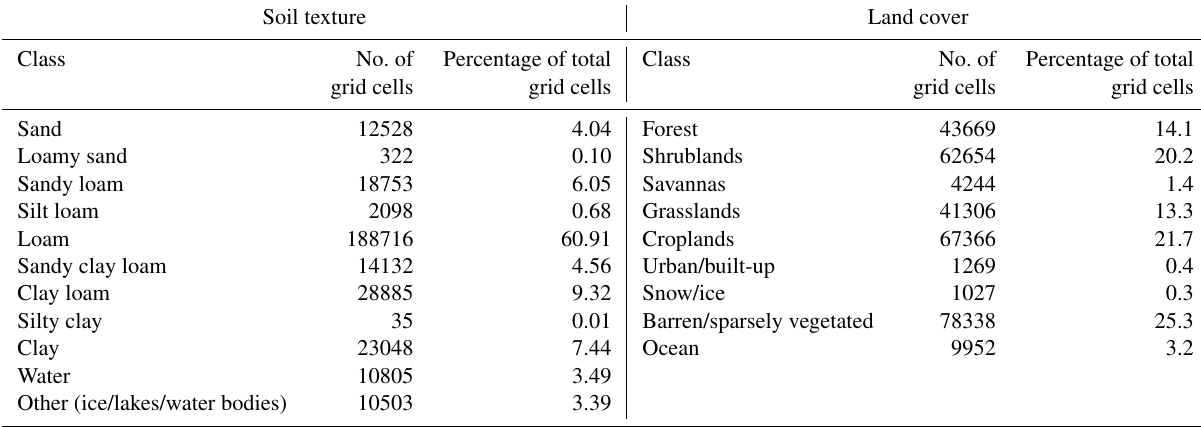
Table A1. List of soil texture and land cover classes (and their respective percentages) found within the study domain presented in Fig. 1. Soil texture